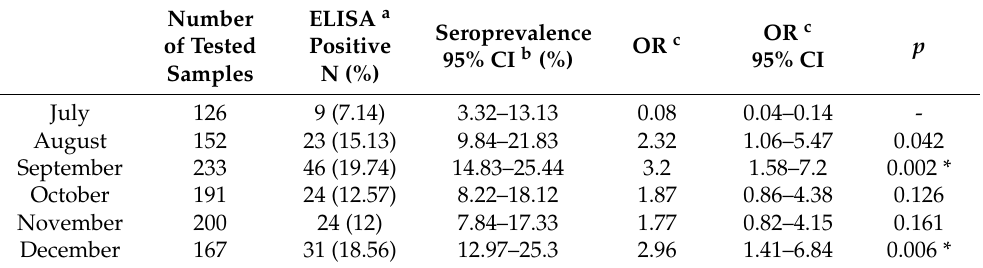
Table 1. Monthly seroprevalence rate in dogs admitted to the Veterinary Teaching Hospital